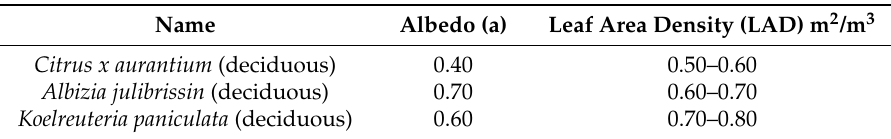
Table 2. Greenery